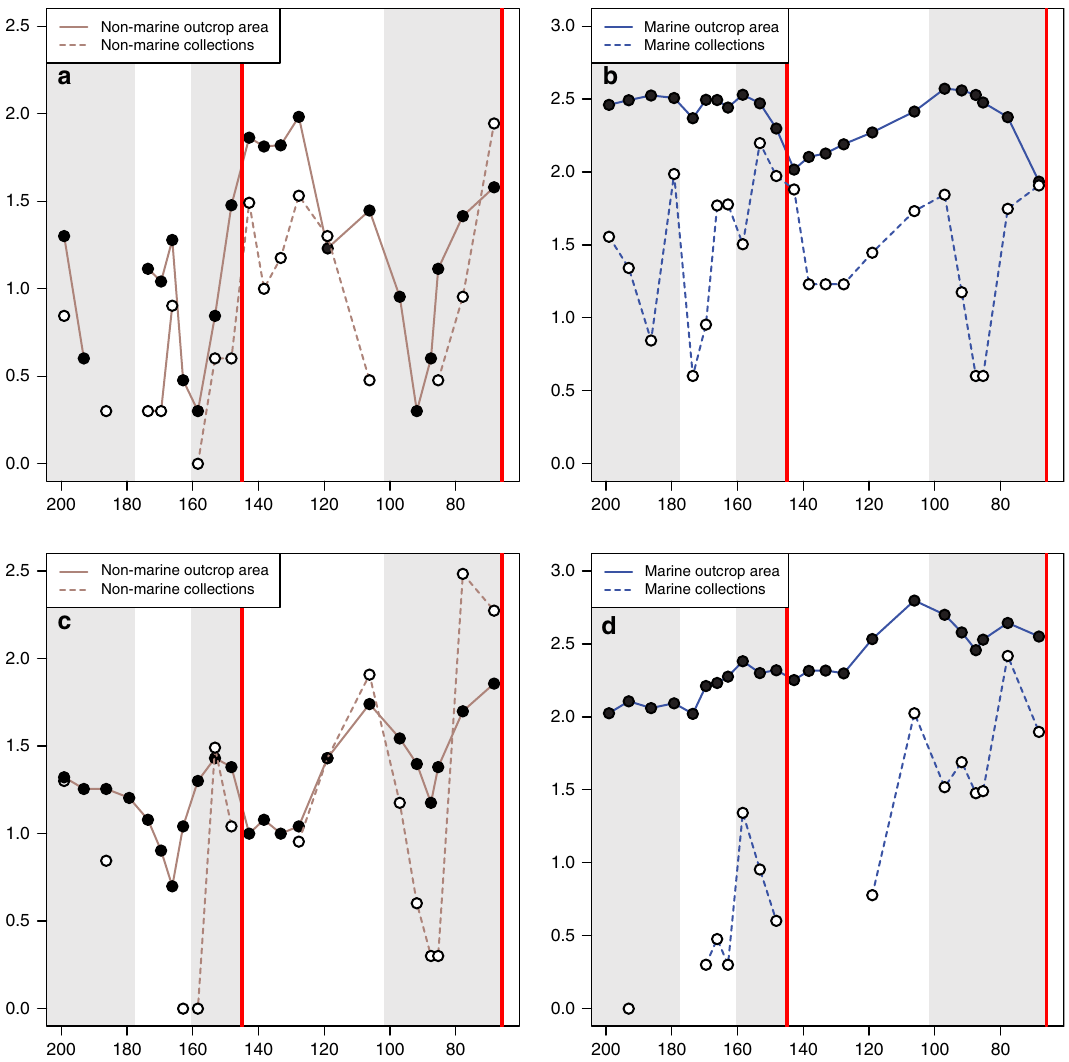
Figure 4 | Regional outcrop area and collection counts. For the ( a ) non-marine record of Europe; ( b ) marine record of Europe ( c ) non-marine record of North America; and ( d ) marine record of North America. European outcrop area from Smith and McGowan 49 , and North American outcrop area from Peters and Heim 43 . Note the discontinuity between the availability of the rock record and the number of collections in the earliest Cretaceous of North